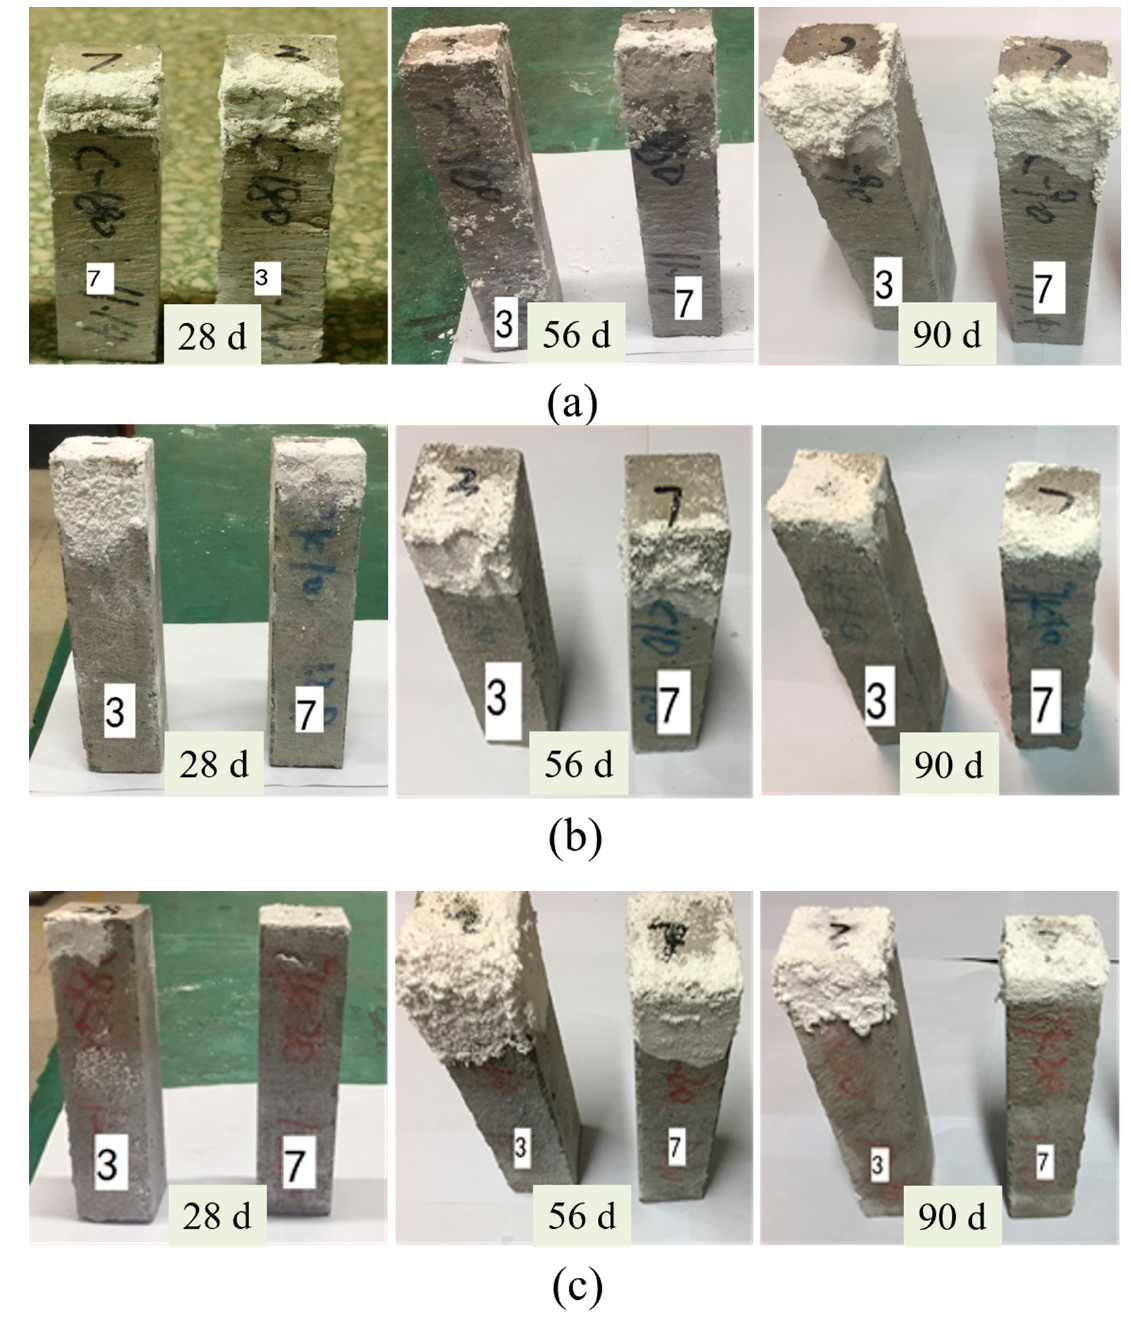
Figure 7. Visual appearance of mortar exposed to sulphate attack: ( a ) C; ( b ) M1; ( c ) M2.